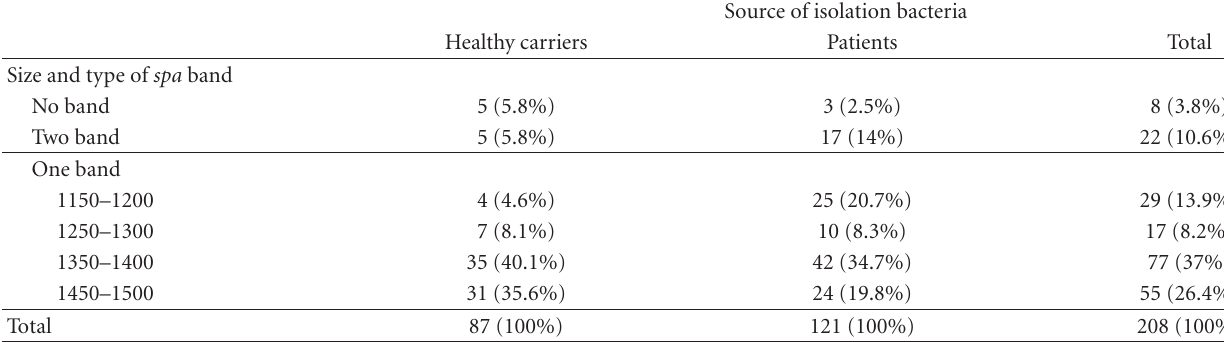
Table 2: Distribution of spa gene in S. aureus strains according their source. Source of isolation